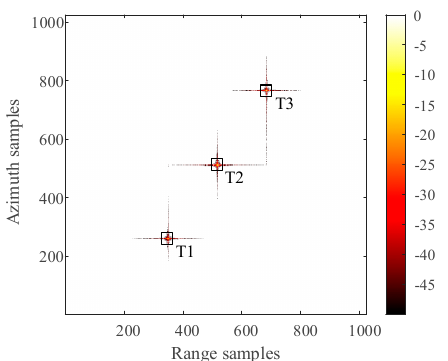
Figure 8. The imaging result of three-point targets with the range-Doppler (RD) algorithm for azimuth full sampling data (dB).